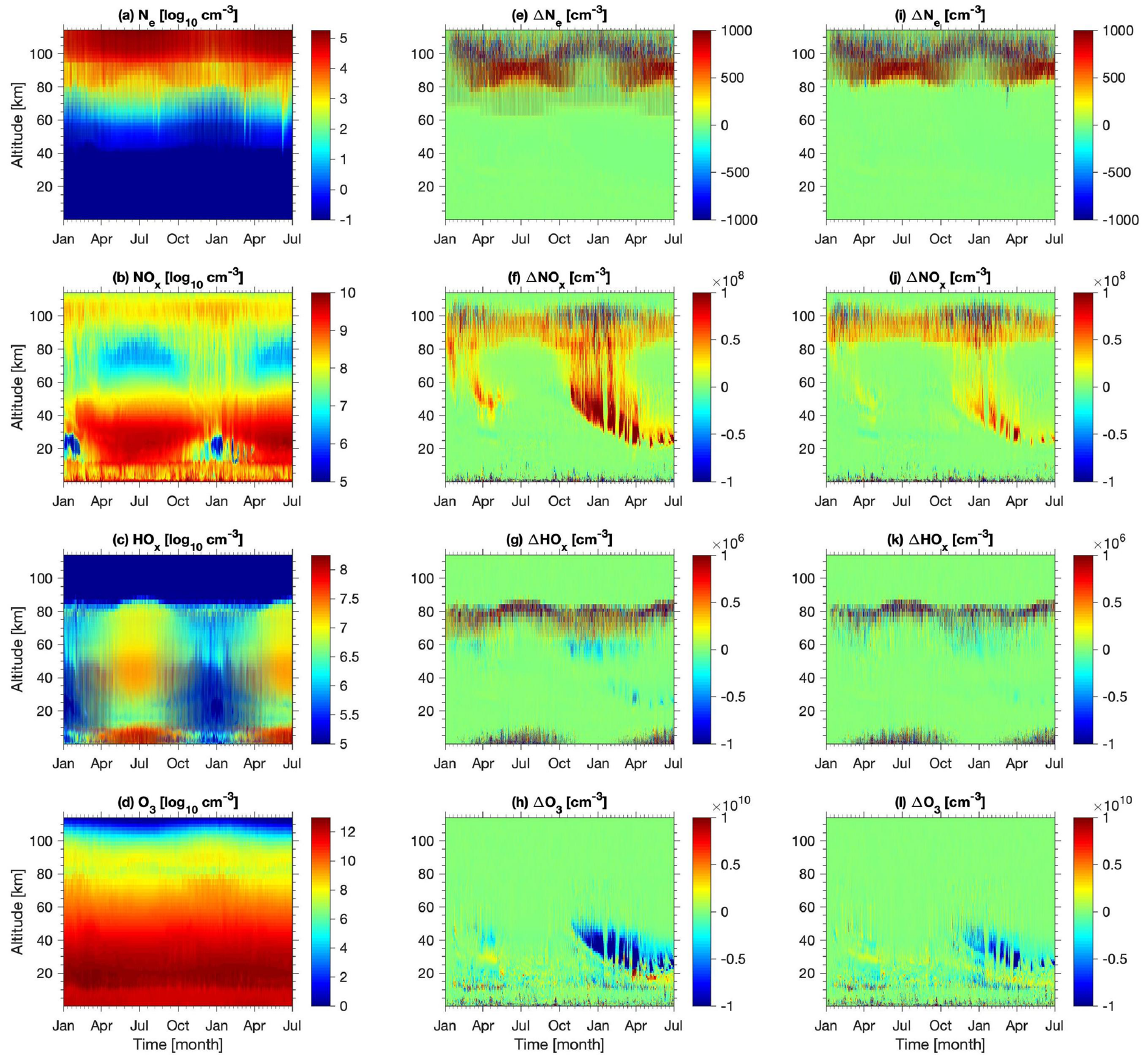
Figure 2. Simulation results for a selected location in the Northern Hemisphere, namely the Tromsø radar site (69.6 ◦ N, 19.2 ◦ E). Left column: (a) electron concentration N e , (b) NO x , (c) HO x , and (d) O 3 from the full-PsA simulation. Centre column: absolute differences in (e) N e , (f) NO x , (g) HO x , and (h) O 3 between the full-PsA and no-PsA simulation. Right column: panels (i) to (l) are the same as the centre column but showing differences between the thermo-PsA and no-PsA